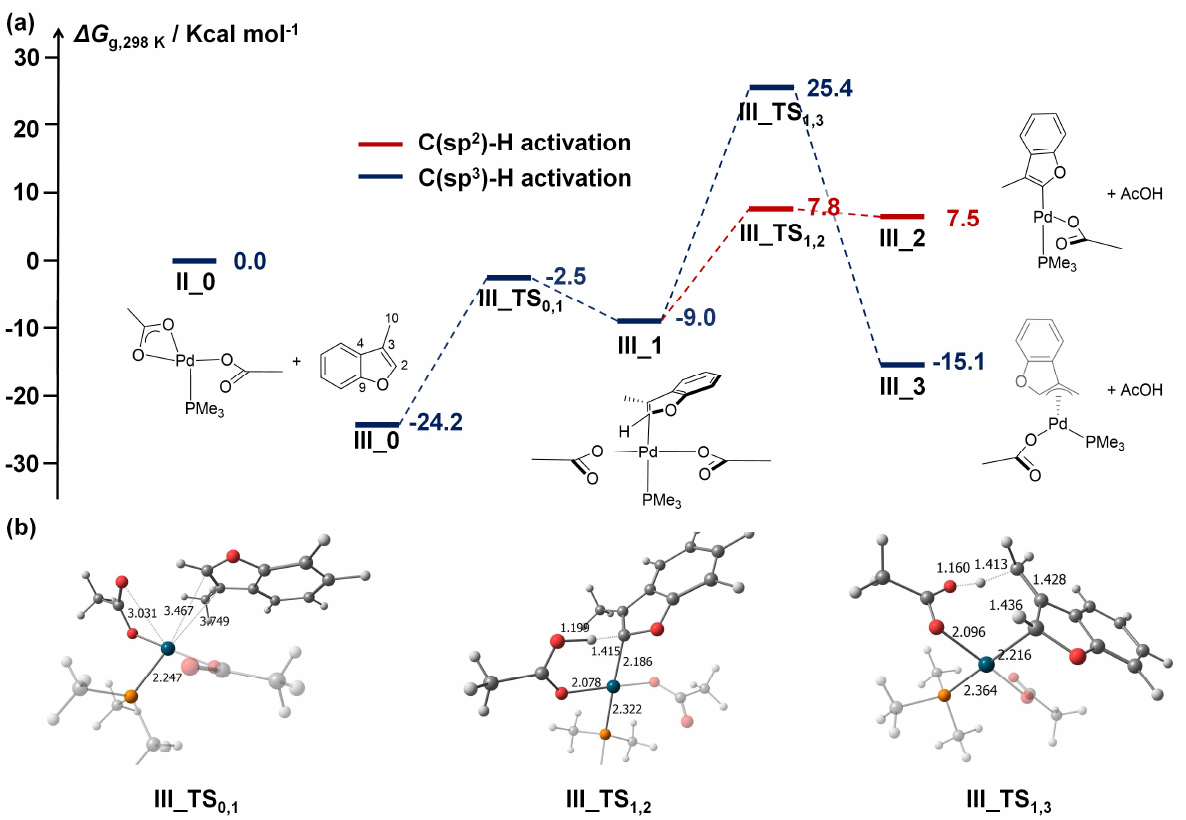
Figure 4. ( a ) Free energy reaction profile for C(sp 2 )−H (red) and C(sp 3 )−H (blue) activation by III . Numbers are Δ G in water at 298 °C (energies in kcal/mol). ( b ) Optimized geometries of transition states with selected bond lengths (Å). The spectator acetate and trimethylphosphine groups are drawn translucent for clarity.